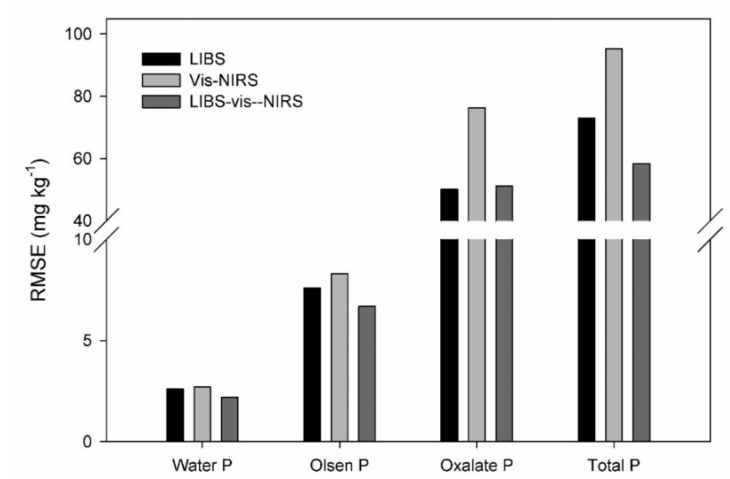
Figure 6. RMSE results of the best LIBS, vis-NIRS and LIBS-vis-NIRS models for water-extractable P, Olsen P, Oxalate-extractable P and total P pools. The variable selection method used is specified on top of each bar.